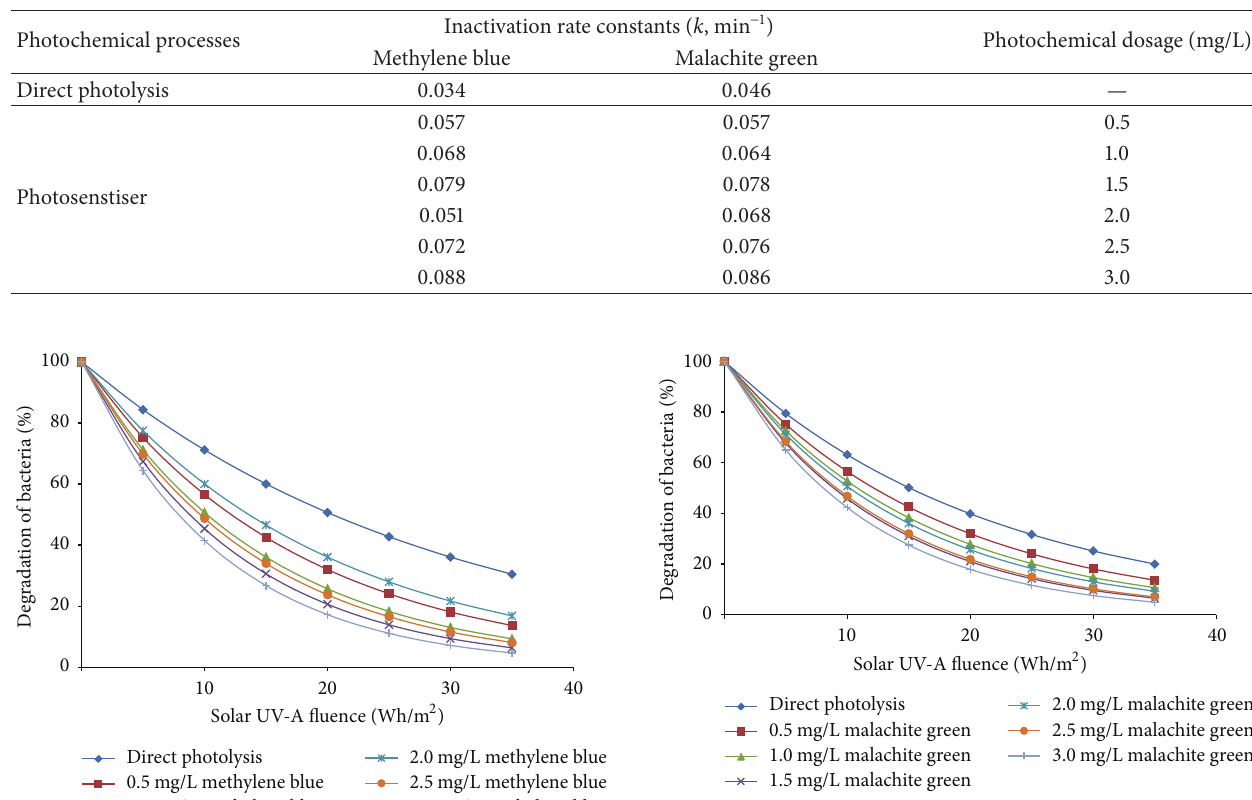
Table 2: Inactivation rate constants ( k , min − 1 ), for direct photolysis (solar radiation), and photosensitisers methylene blue and malachite green at varying concentrations of 0.5 to 3.0 mg/L.